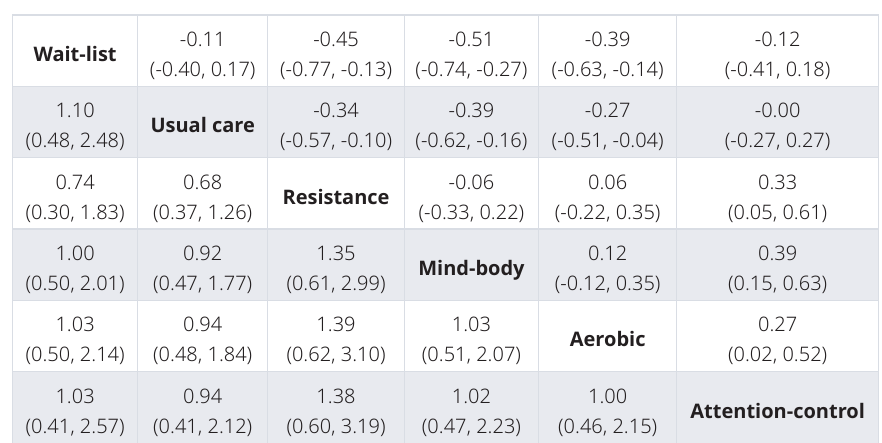
Table 3. League table for head-to-head comparisons.